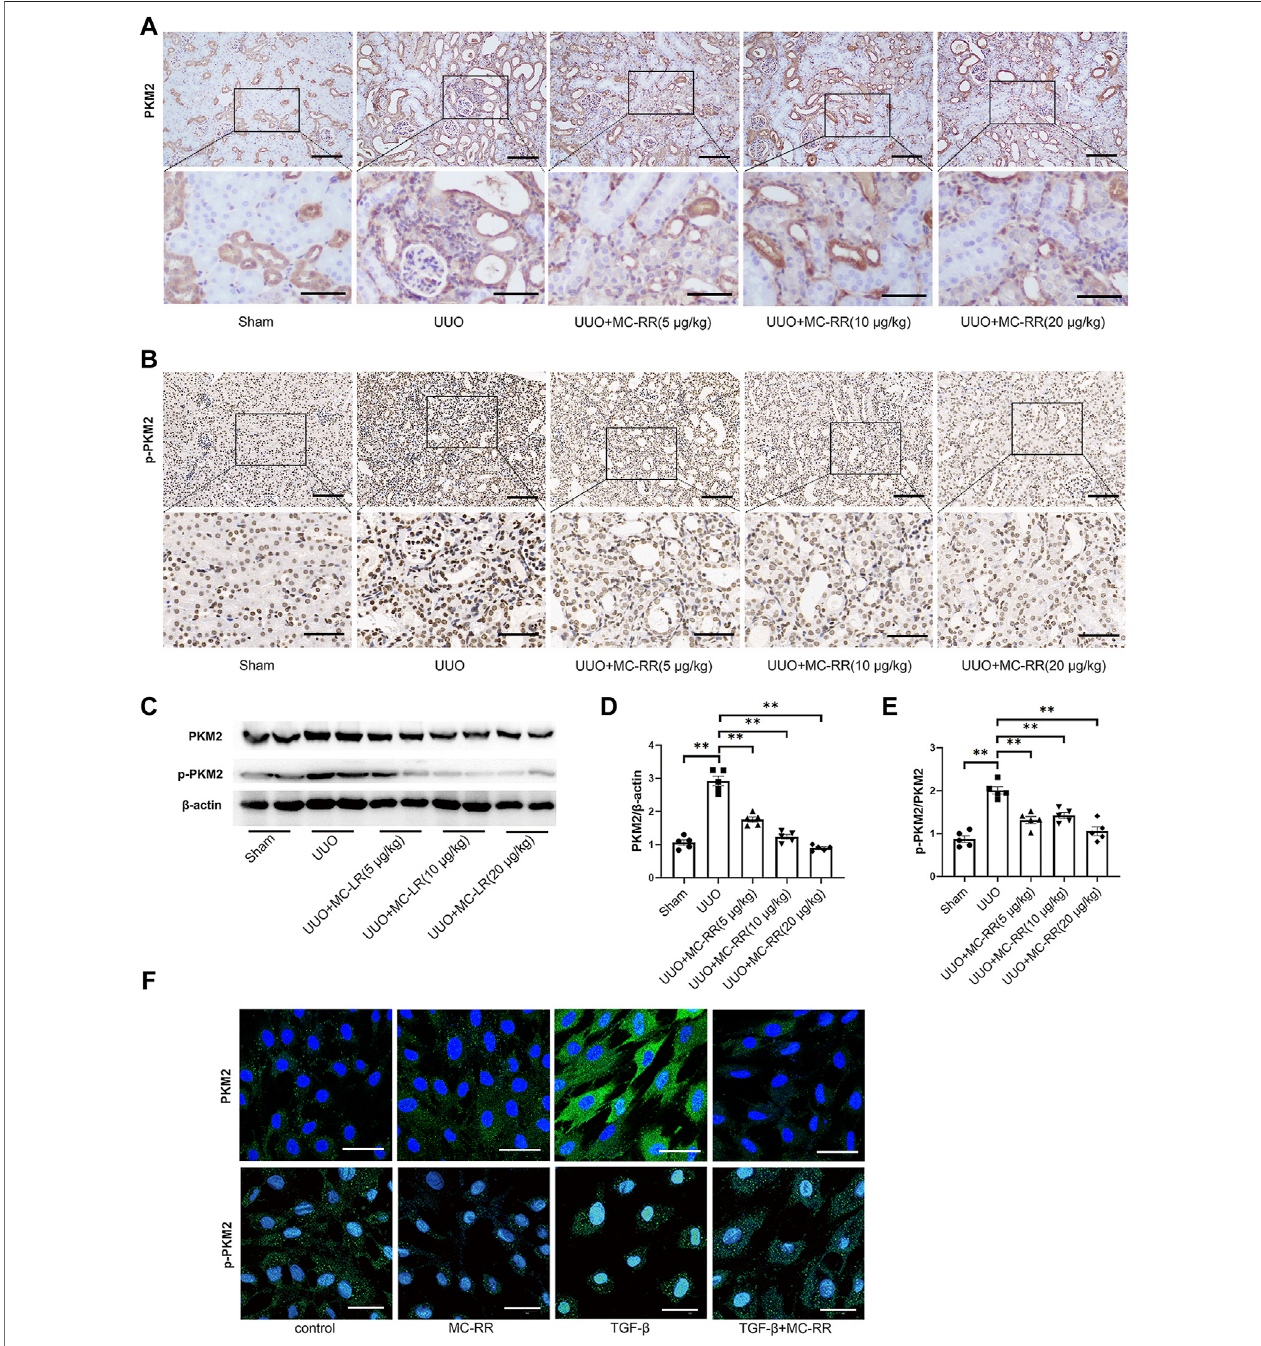
FIGURE 4 | Microcystin (MC)-RR reduces the level of pyruvate kinase M2 (PKM2) and p-PKM2 in the kidney tissues of unilateral ureteral obstruction (UUO) mice and in NRK-49F exposed to TGF- β . UUO mice were treated with MC-RR as described in Figure 2 . (A,B) Expression levels of PKM2 and p-PKM2 in mice kidney tissue sectionsweredetectedbyimmunohistochemistry(scalebar:100and50 μ m). (C – E) Totalproteinwasextractedfromkidneytissuesfordeterminingtheexpressionlevel of PKM2 and p-PKM2 protein by western blot. * p < 0.05 determined by one-way ANOVA with S – N – K post hoc analysis. (F) NRK-49F cells were left alone or cultured with TGF- β 1 (5 ng/ml) for 48 h. Some of the cultured cells were also treated with 0.1 μ M MC-RR. The subcellular localization and protein expression of PKM2 and p-PKM2 were detected by immuno fl uorescence technique (scale bar: 40 μ m).